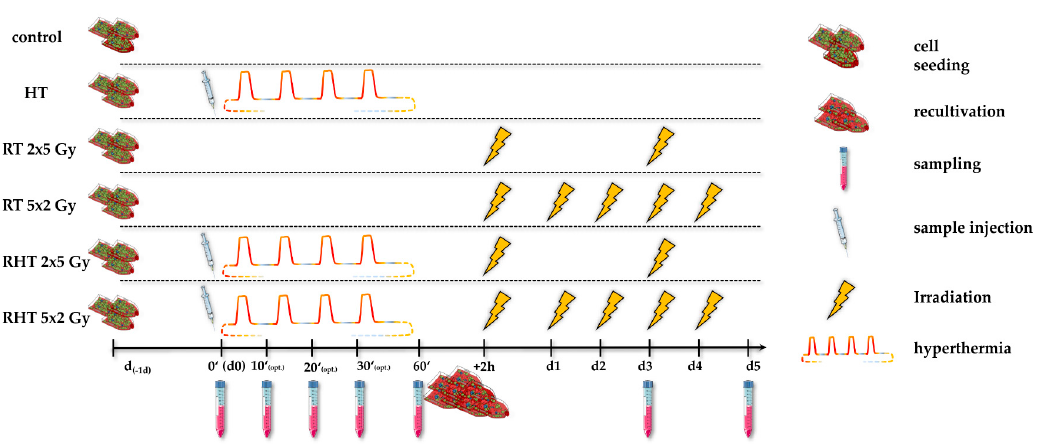
Figure 17. Experimental treatment set-up: The cells were seeded cell line-dependent one day prior to the treatment (d -1d ) for not more than 90 % of confluency during the whole treatment, e.g., 3 × 10 5 cells per 75 cm 2 t-flask of MDA-MB-231 for sampling on day 5 in the control arm. Standard sampling in all arms was performed on day 0 (d0), d3 (72h) and d5 (120h). In the HT and combinatory arm, i.e., radiotherapy & hyperthermia (RHT), sample injection of 1x10 7 cells into the HT system was done at time point d0, followed by an effective heating session of at most 60 min. After the HT treatment, cells were recultivated into 75 cm 2 t-flasks according to their subsequent treatment. Irradiation in the radiotherapy arm (RT) and combinatory RHT arm was performed in 75 cm 2 t-flasks with clinically relevant doses of either 2 × 5 Gy or 5 × 2 Gy. Irradiation in the respective RT and RHT arms was always performed at the same time.